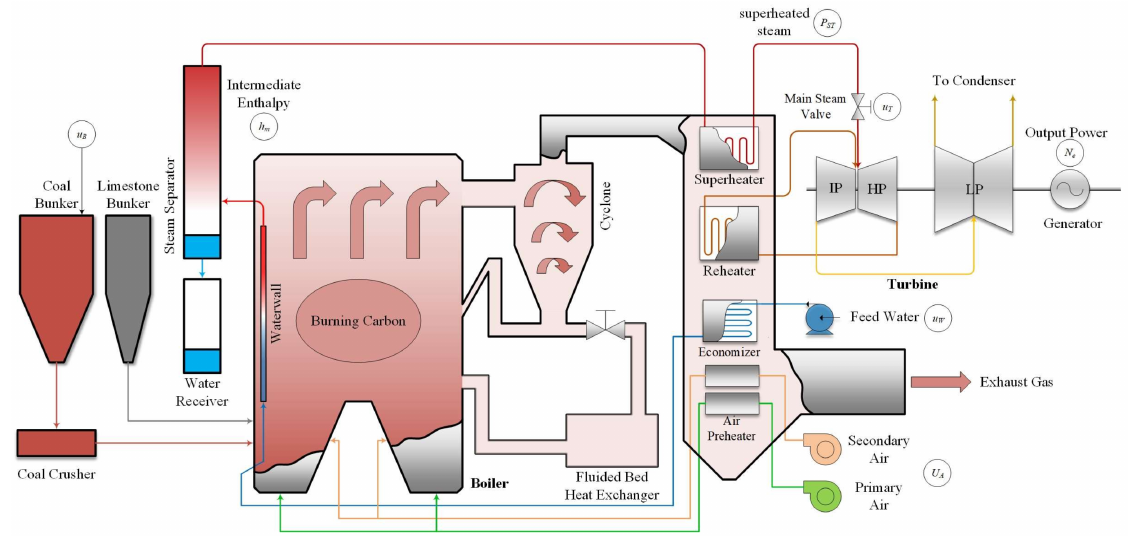
Figure 1. Schematic of a USC CFB boiler